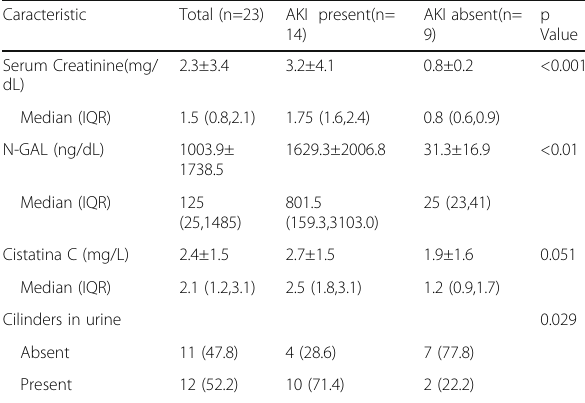
Table 1 (abstract 001268). Baseline sociodemographic characteristics of the study patients Caracteristic